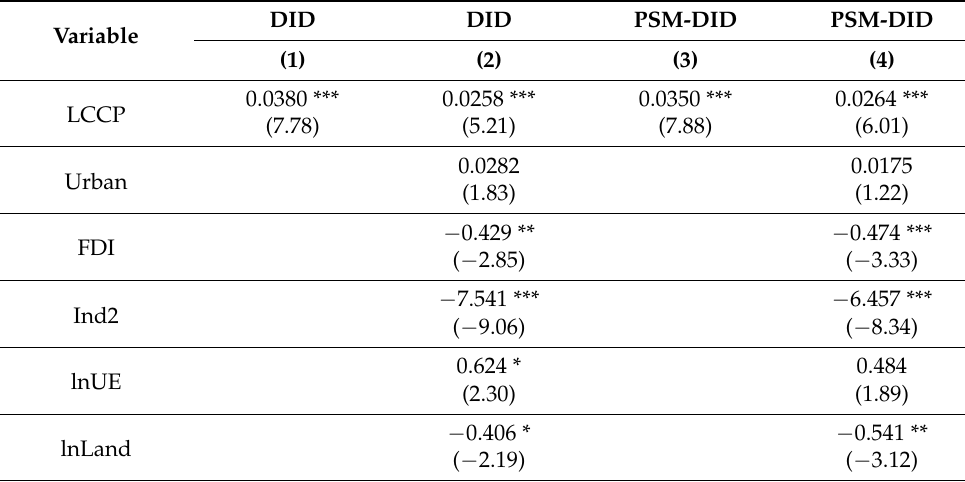
Table 4. The impact of LCCP city on the GUEUL.